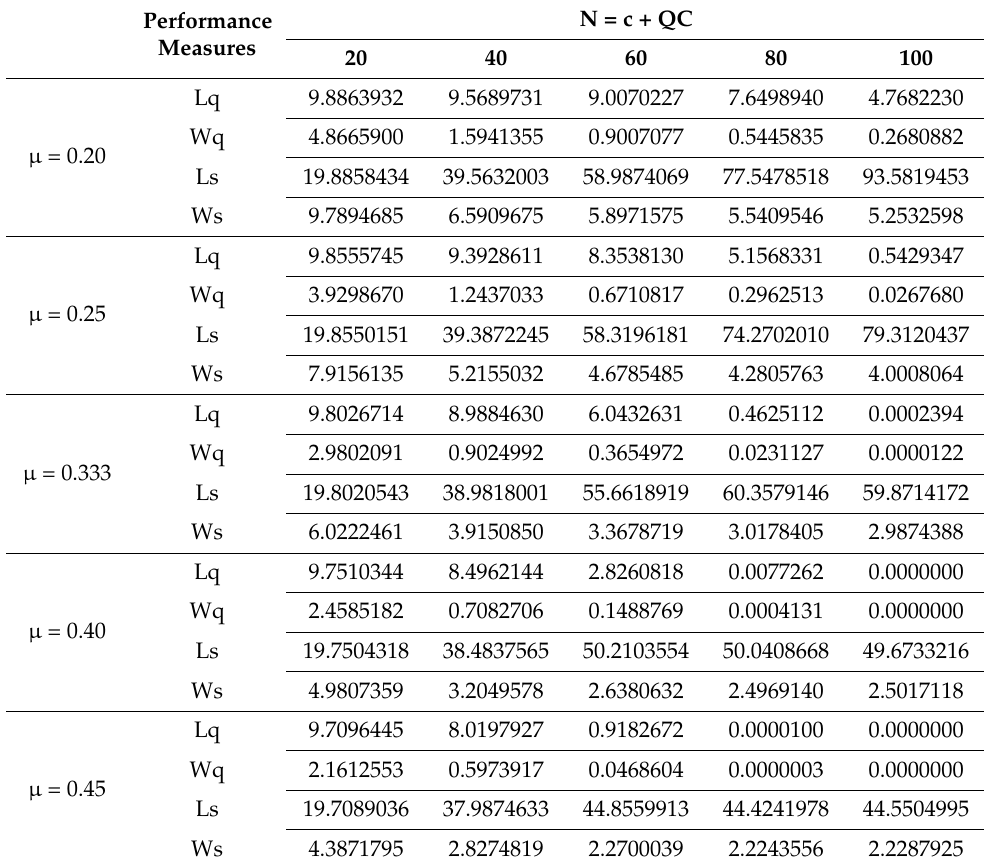
Table 12. The effect of variation of parameter µ on performance measures, expected number of customers in system (Ls), expected number of customers in queue (Lq), expected waiting time in system (Ws), and expected waiting time in queue